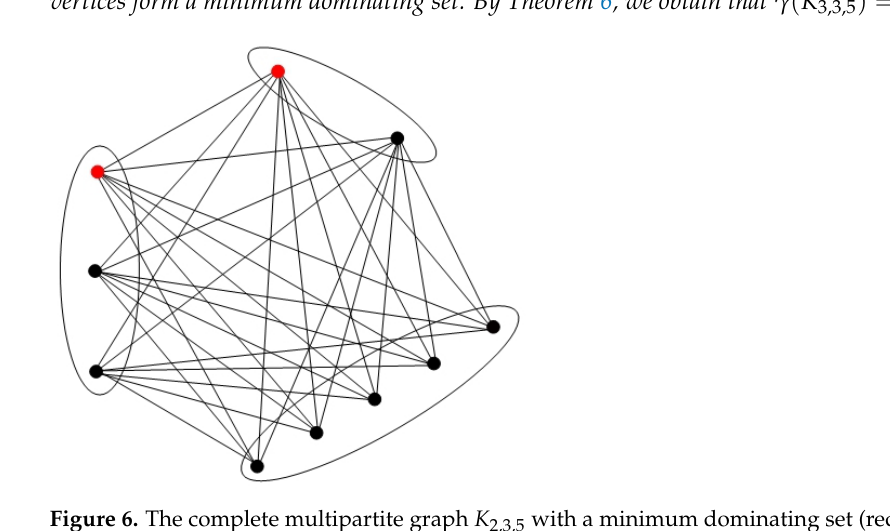
Figure 6. The complete multipartite graph K 2,3,5 with a minimum dominating set (red vertices). The next subsection studies the locating-dominating number of